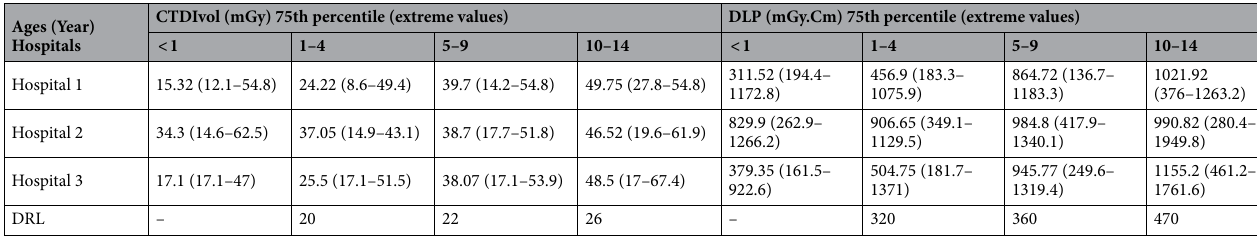
Table2. Dosimetric parameters recorded on the three CT scanners used compared to the Diagnostic Reference Levels (DRL) of France